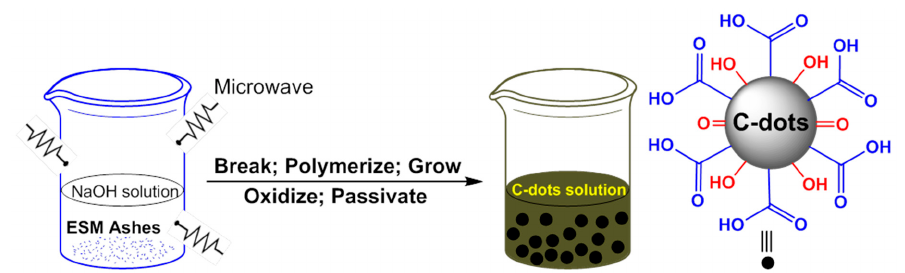
Figure 2. Schematic illustration of a MW-assisted synthesis of C-dots. Adapted with permission from [30]. Copyright (2012) Royal Society of Chemistry.